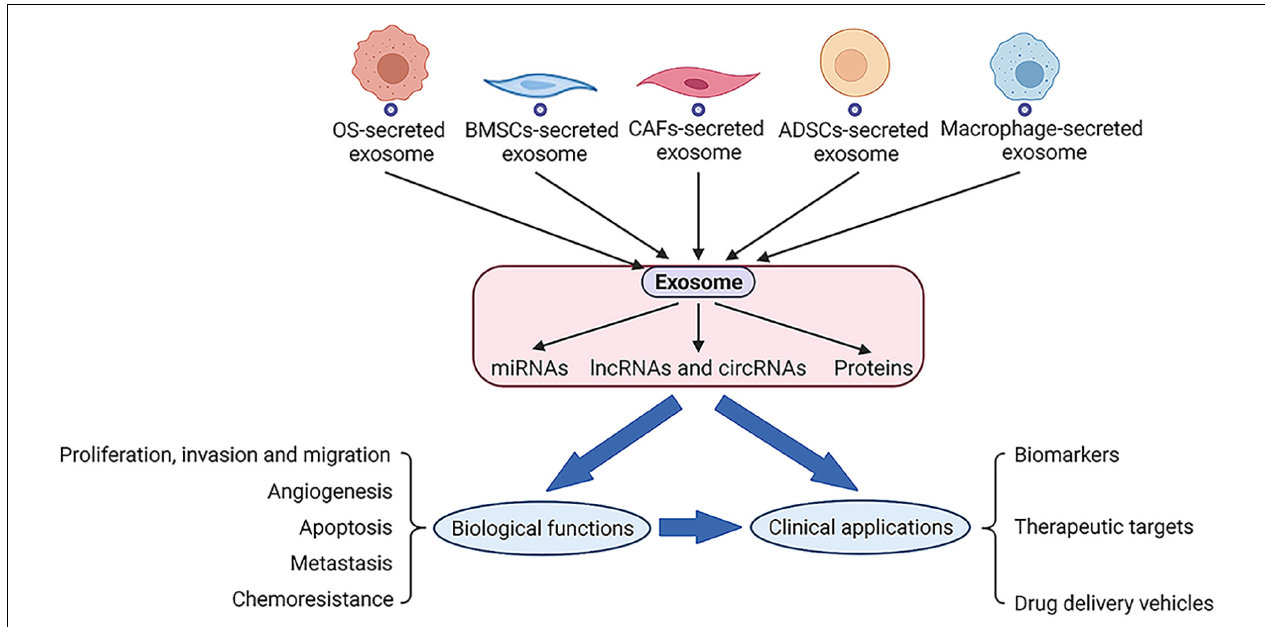
FIGURE 5 | Exosomes could be secreted by series of cells and exosomal cargoes such as RNAs and proteins will perform biological functions along with exosomes, which may also lead to related clinical applications.